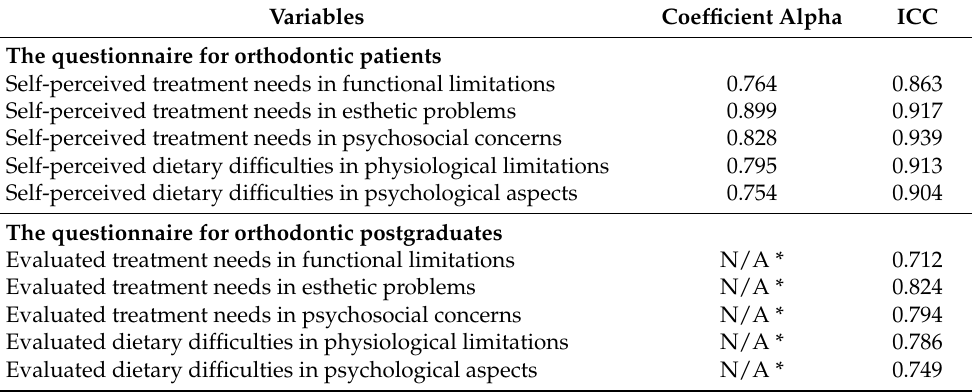
Table 1. Cronbach’s alpha and intraclass correlation (ICC) of each construct in the pilot testing. Variables Coefficient Alpha